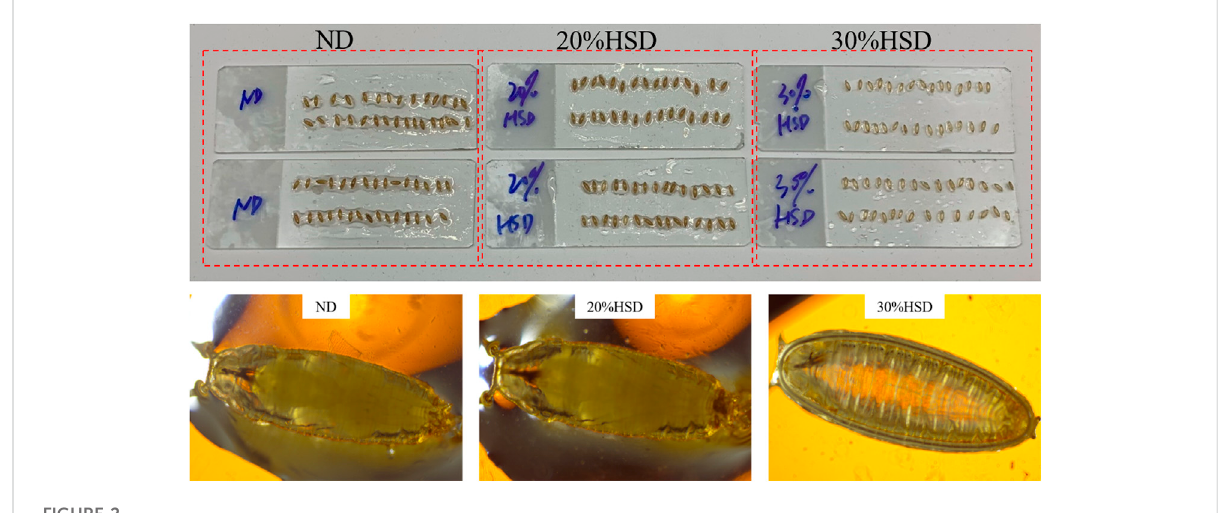
FIGURE 2 Photographs by camera and microscope (20×) of pupa after HSD